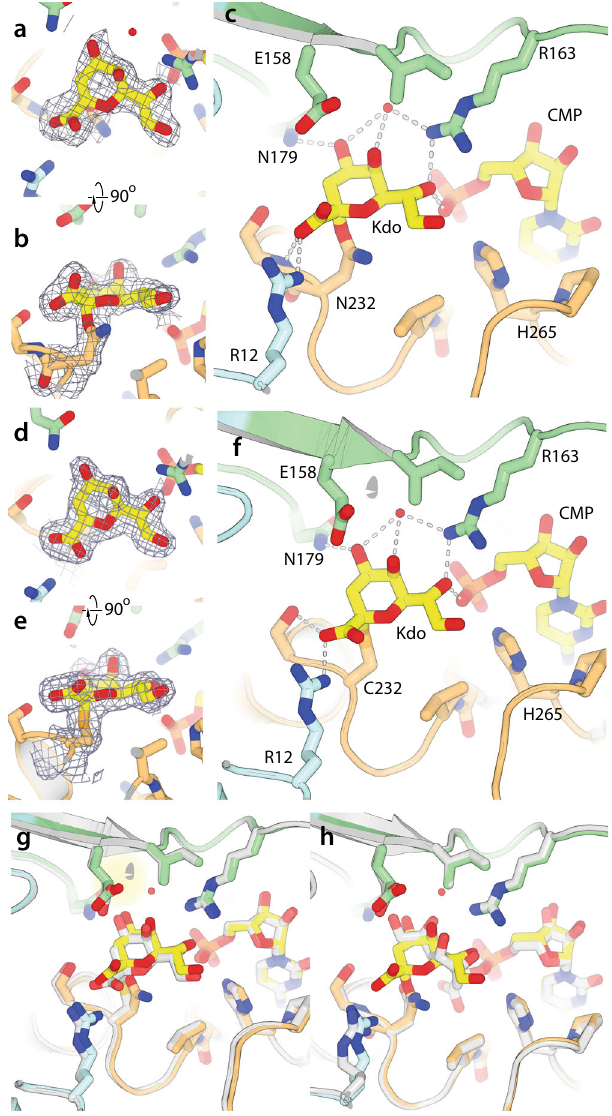
Fig. 4 | Structures of α -Kdo adducts. a , b Electron density for the WbbB GT99 - Asn232 – α -Kdo adduct (2mFo-DFc map contoured at 1.0 σ ). c Details of the inter- actionsmade bythe WbbB GT99 -Asn232 – α -Kdocovalentintermediate adductinthe active site. d , e Electron density for the WbbB GT99 -Cys232 – α -Kdo adduct, (2mFo- DFc map contoured at 1.0 σ ). f Details of the interactions made by the WbbB GT99 - Cys232 – α -Kdo covalent intermediate adduct in the active site. g Superposition of the WbbB GT99 -Asn – α -Kdo and WbbB GT99 -Cys – α -Kdo adduct structures. The WbbB GT99 -Cys – α -Kdo adduct structure is shown in white. h Superposition of the CMP- β -Kdo complex (in white) on the WbbB GT99 -Asn232 – α -Kdo adduct struc- ture. The Kdo residue is completely fl ipped in the active site, but the ridge of hydroxyl groups O4 – O8 mediate interactions with the same residues in both